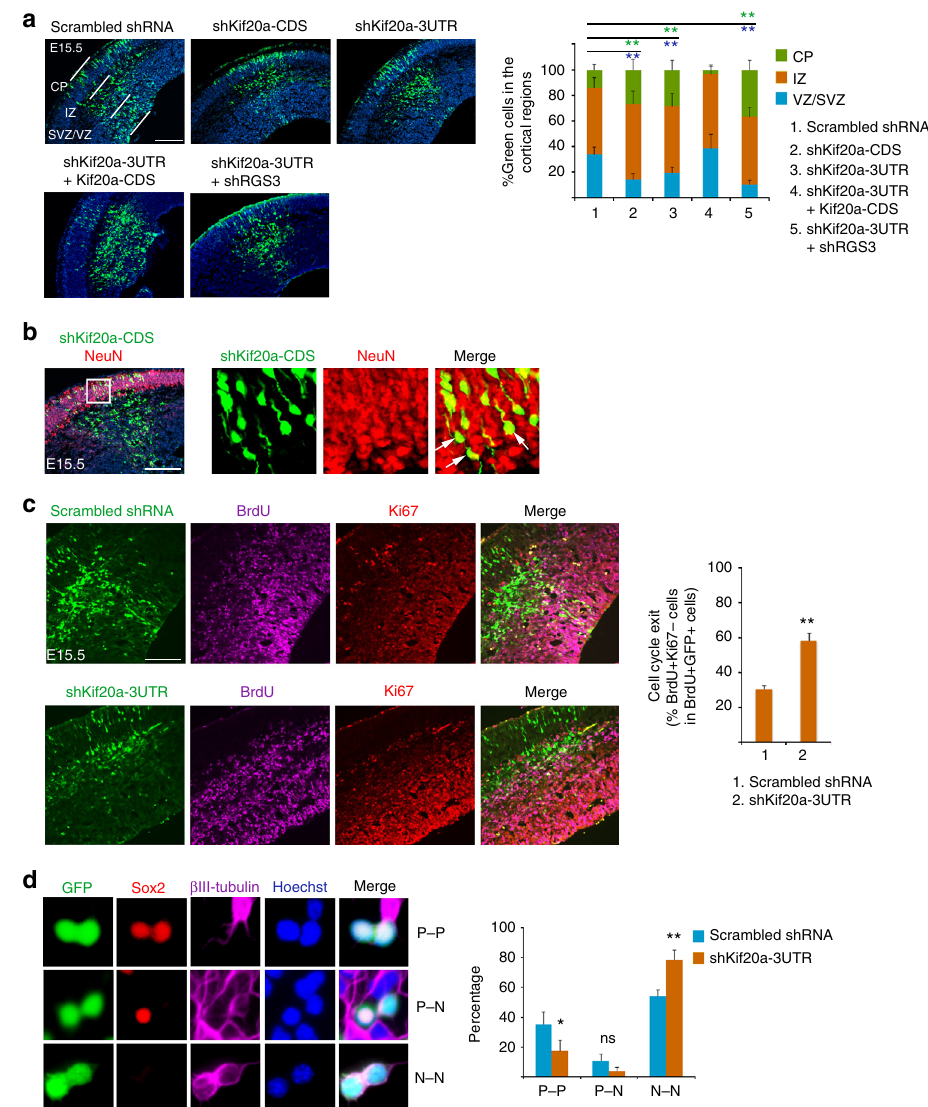
Fig. 2 Knockdown of KIF20A causes neuronal differentiation in NPCs. a DNA plasmids were introduced into the cortex by IUE at E13.5 and the brains were analyzed at E15.5. The shRNA vector carried a ubiquitin promoter-GFP expression cassette for visualization of transfected cells. Distributions of transfected cells in different radial regions of the cortex were scored (5 – 8 electroporated brains for each plasmid or combination of plasmids were used for quanti fi cation). The symbol ** (in green and blue fonts) indicates P < 0.01 with respect to the CP and VZ/SVZ distributions compared to control shRNA. Scale bar represents 100 μ m. Error bars represent SD. CP: cortical plate, IZ: intermediate zone, VZ/SVZ: ventricular/subventricular zone, CDS: coding sequence, 3 ’ UTR: 3 ’ untranslated region. b At 2 days after IUE-based electroporation, shKif20a-expressing cells (GFP + cells) in the CP were positive for NeuN, indicating that the cells were neuronal progeny. Arrows indicated examples of GFP + NeuN + cells. Scale bar represents 100 μ m. c DNA plasmids were introduced into the cortex by IUE at E13.5, BrdU was administered at E14.5, and the brains were collected at E15.5. Sections of electroporated brains were co-stained for incorporated BrdU and proliferating marker Ki67. Cell cycle exit index was calculated using the ratio of BrdU + Ki67 - GFP + cells over the total population of BrdU + GFP + cells. ** P < 0.01 (Student ’ s t -test). Scale bar represents 100 μ m. d Dissociated cells from cortices electroporated with shKIF20A-3 ’ UTR or control plasmid were cultured for 20 h and co-stained for Sox2 and β -III-tubulin. The percentage of paired cells showing P – P, P – N, and N – N divisions were scored (control shRNA, 451 cell pairs of three experiments; shKIF20A-3 ’ UTR, 368 cell pairs of three experiments). Representative images of paired cells shown here were expressing shKIF20A-3 ’ UTR. * P < 0.05, ** P < 0.01 (Student ’ s t -test); ns: not signi fi cant. Error bars represent